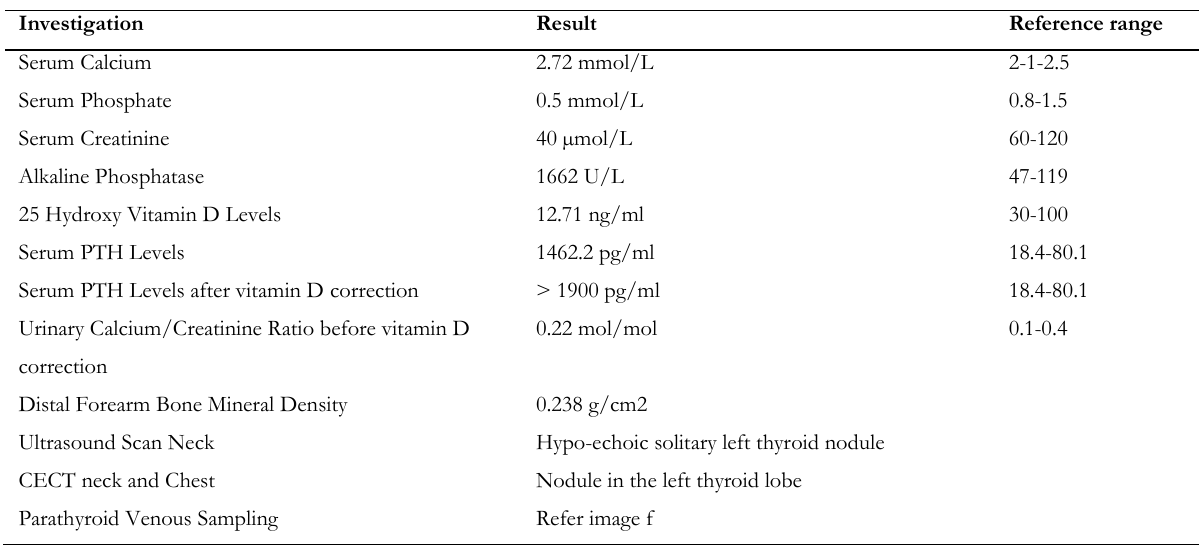
Table 1: Summary of